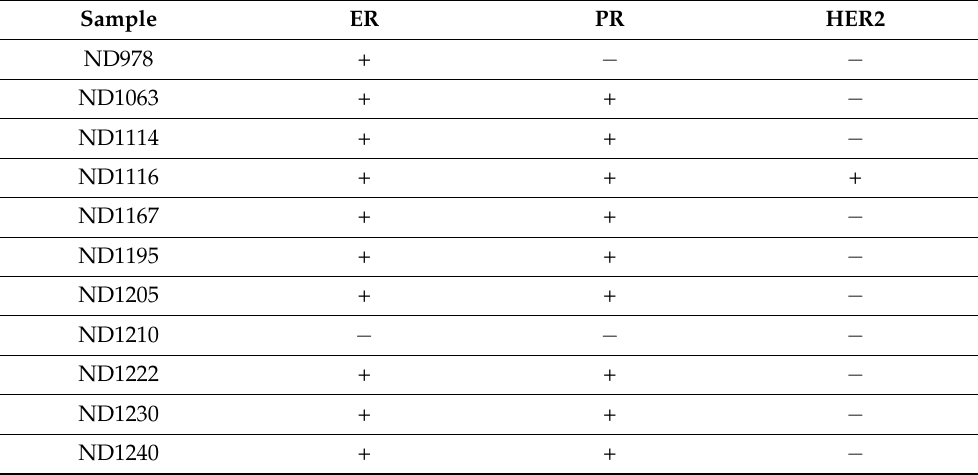
Table 1. Characteristics of the patients’